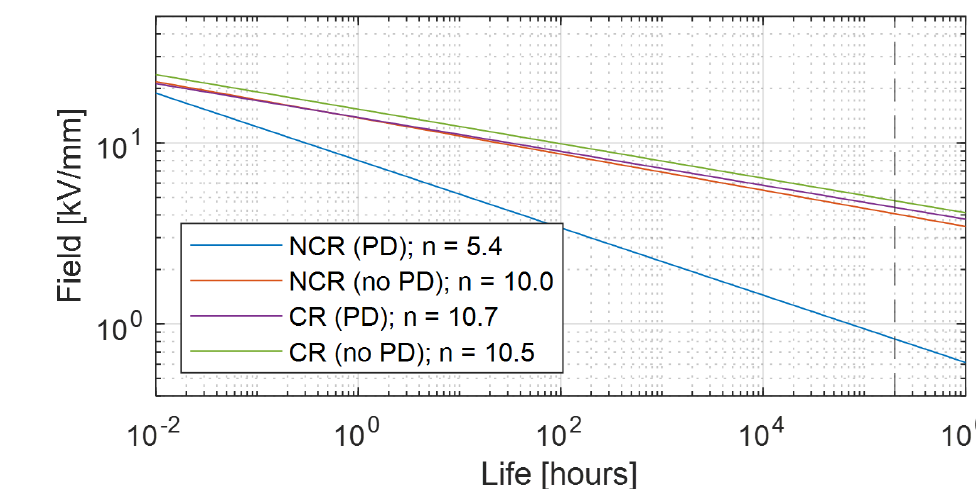
Figure 4. Life lines for CR and NCR materials, under PD (as in Figure 3) and without PD. The inverse of the slope ( n , Equation (1)) drops down for NCR (from 10 to 5.4) when PD are active, but it remains almost constant (about 10) for CR materials. The design life, L D , (2 × 10 5 h) is indicated (vertical dotted line).